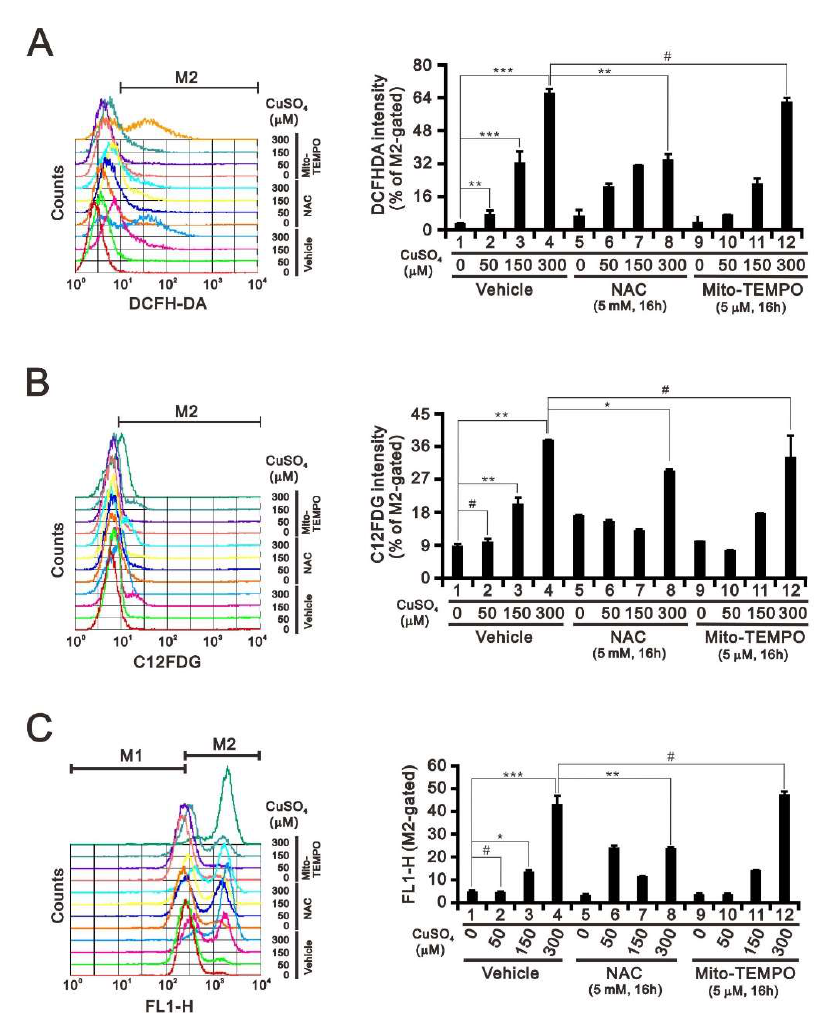
Figure 3. E ff ects of copper sulfate on the ROS, senescence, and mitochondrial membrane potential. ( A – C ) HeLa cells were incubated with the indicated concentrations of copper sulfate for 16 h in the presence of 5 mM NAC or 5 µ M Mito-TEMPO, after which the live cells was stained with ( A ) 10 µ M DCFH-DA; ( B ) 33 µ M C12FDG; or ( C ) JC-1 and assayed using a flow cytometer. The results are representative of three independent experiments. # p > 0.05, * p < 0.05, ** p < 0.01, and *** p < 0.001.